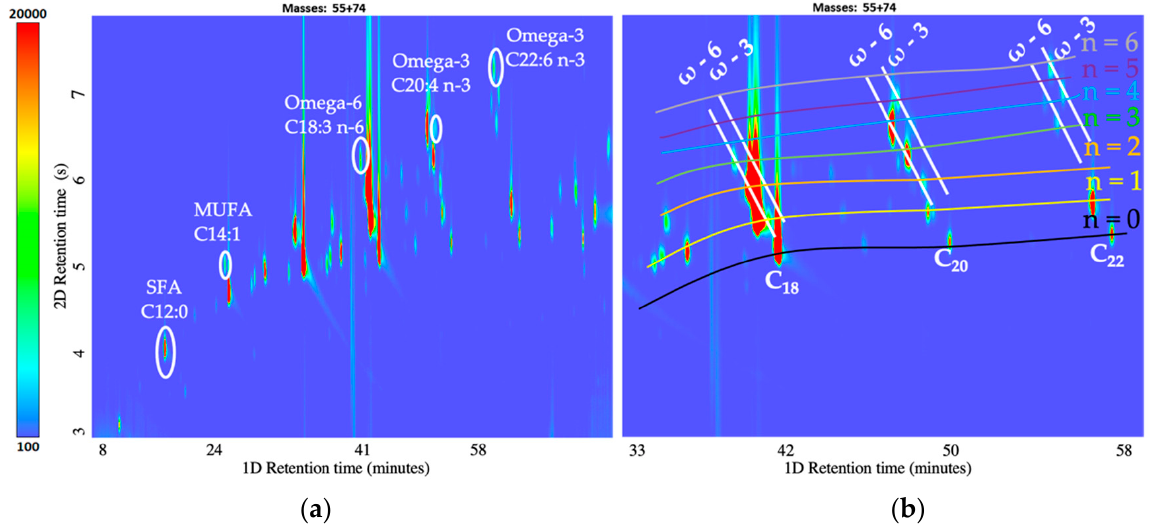
Figure 3. ( a ) Representative of each class selected for response optimization: zoomed-in Contour plot of pooled Human plasma at m / z : 55 + 74. ( b ) Zoomed-in contour plot of pooled human plasma for C 18 to C 22 region at m / z : 55 + 74.